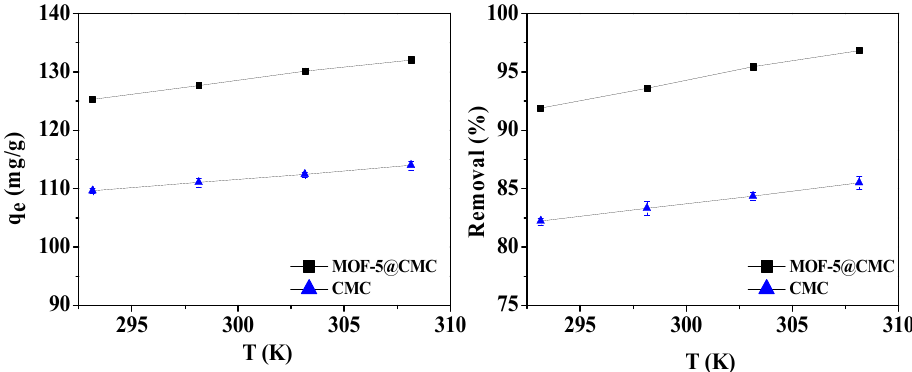
Figure 9. Adsorption capacity and removal rate as functions of temperature.